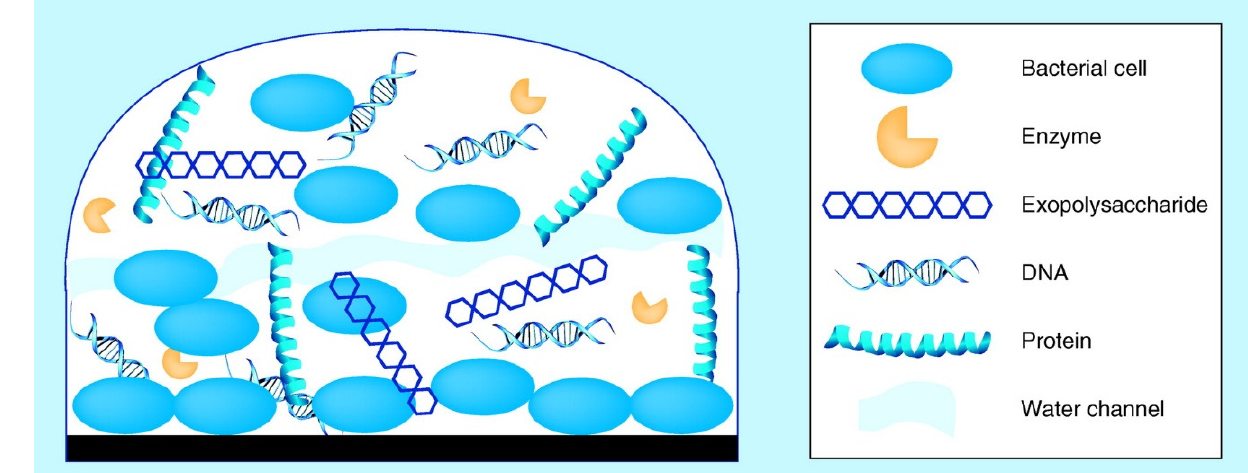
Figure 2. Biofilm structure in the growth and maturation stages [20].